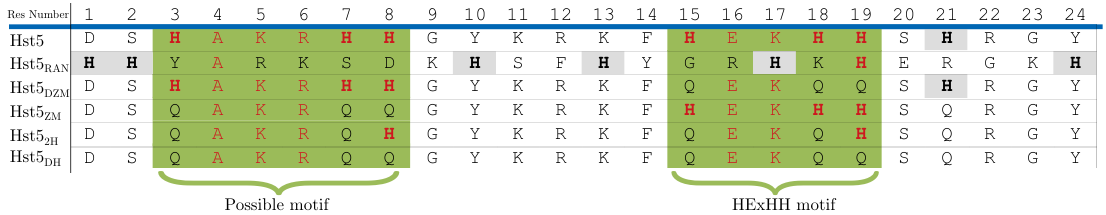
Figure 2. Primary structures of Hst5 and variants . The grey shaded areas denote the histidines and the yellow shaded area with red letters denote the known zinc-binding motif. Hst5 RAN —random distribution of histidines, keeping the total number constant. Hst5 DZM —The histidines in the zinc-motif have been replaced by glutamines. Hst5 ZM —The histidines of the zinc-binding-like motif have been replaced by glutamines. Hst5 2H —Two histidines in the zinc-motif have been replaced by glutamines, and only one of four histidines are left in the rest of the amino acid sequence. Hst5 DH —All the histidines are replaced by